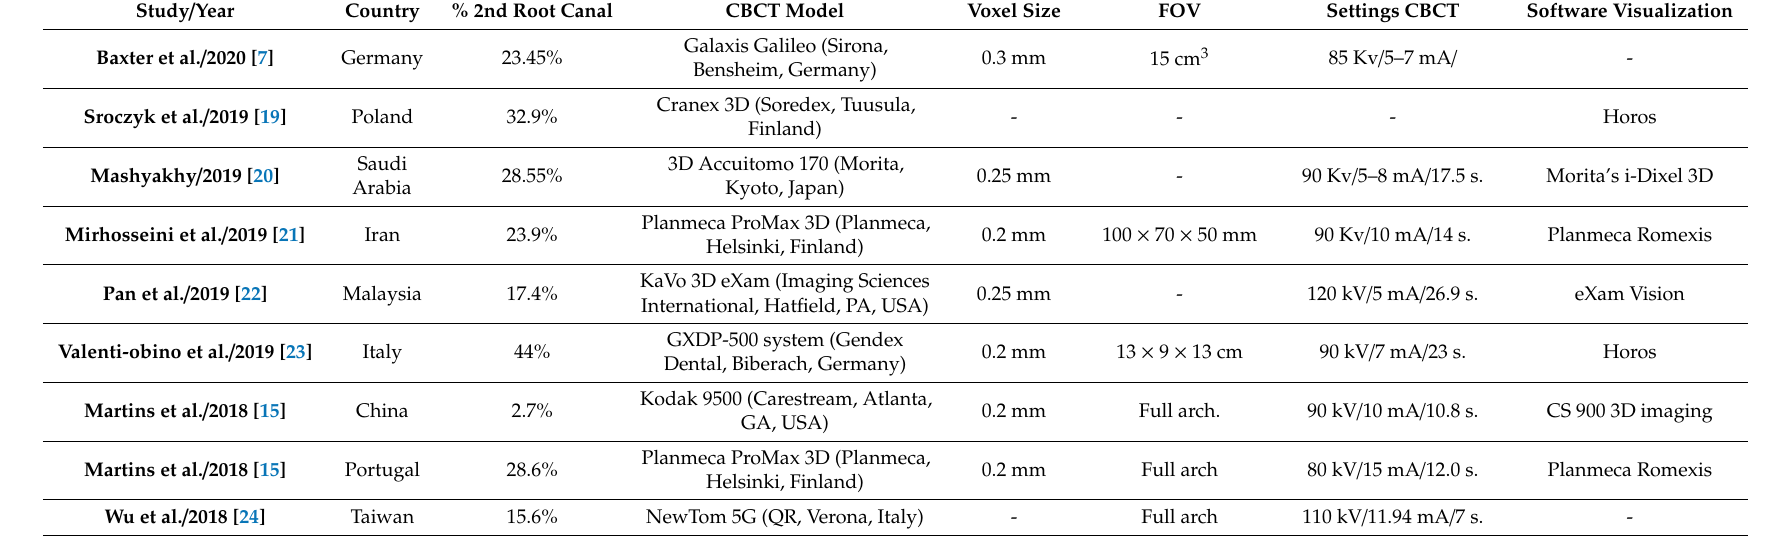
Table 2. Cone-beam computed tomography parameter values of each